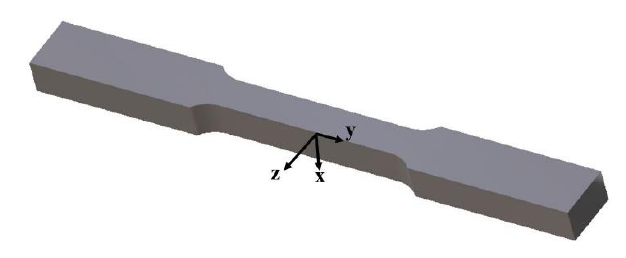
Figure 16: Co-ordinate system for tested samples